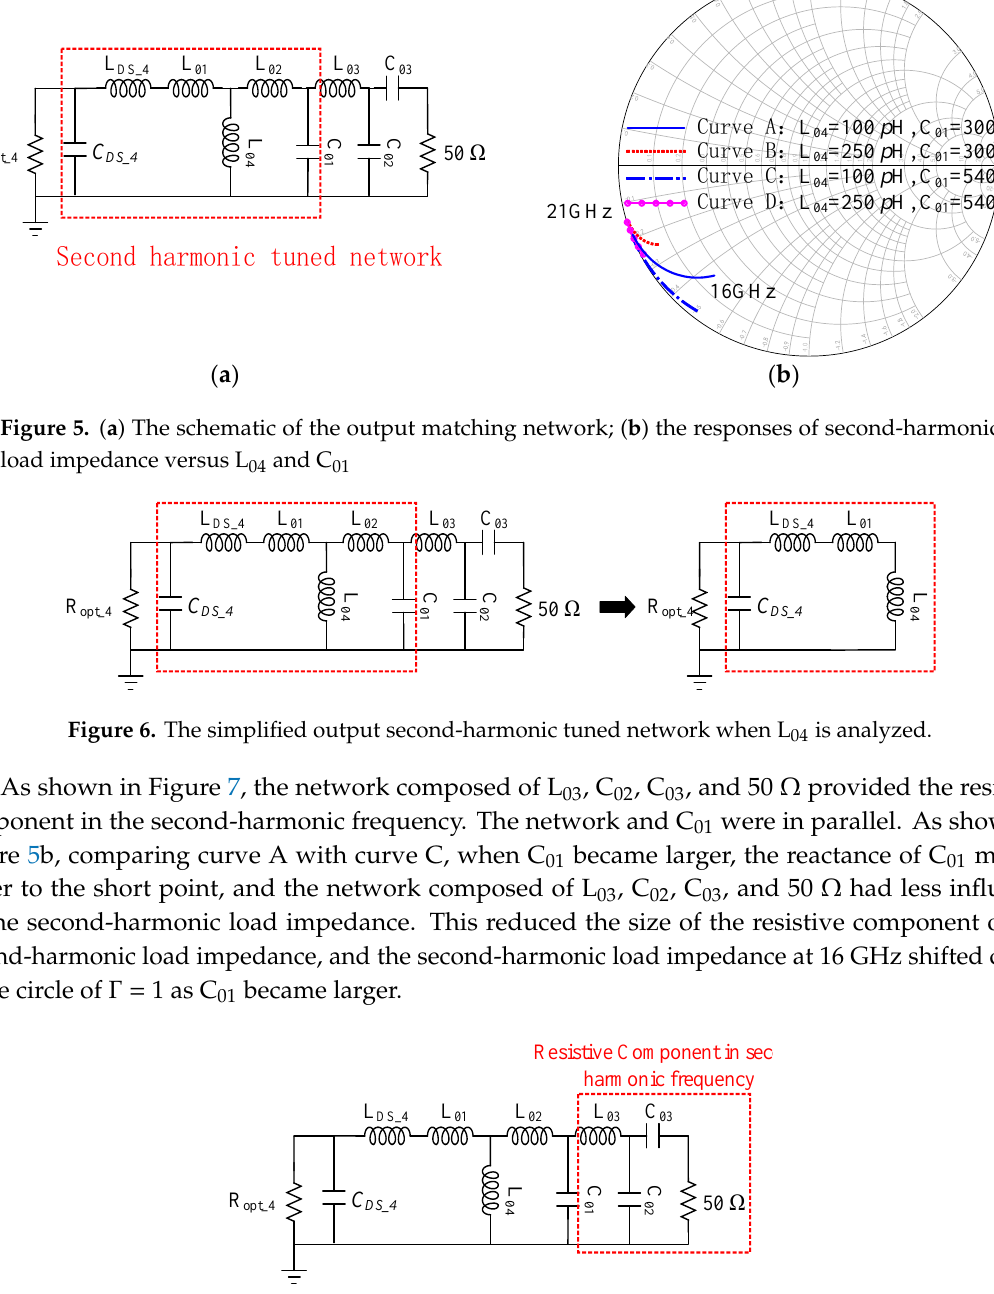
Figure 7. The simplified output matching network when C 01 is analyzed.